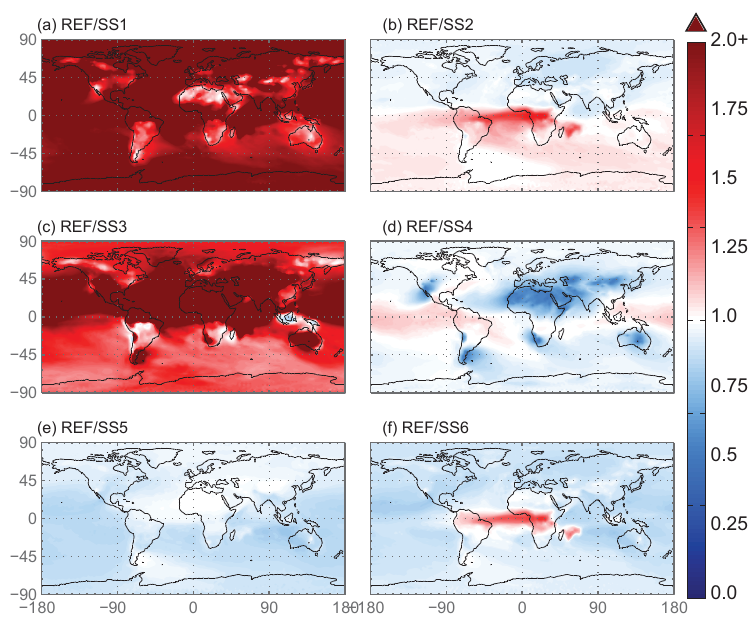
Figure 8. The spatial distribution of the Fes deposition ratio of the reference case over the six sensitivity studies. SS1 corresponds to the case with proton-promoted iron dissolution and no processing via organic ligand dissolution enhancement. The processing mechanism for SS2 is identical to the reference case; however, it uses a sulfate proxy for calculating model oxalate concentrations instead of the OC proxy used in the reference case. SS3 corresponds to a simplified dissolution mechanism defined in Hand et al. (2004); a decay rate is applied when iron comes into contact with a cloud. The SS4 simulation has the same processing mechanism as the reference case; however, the spatial dependence of total and soluble iron on mineralogy at emission is replaced with the average values for these variables from the reference case. SS5 and SS6 are identical to the reference case and SS2, respectively, with the exception of prescribing the pH at 1 when sulfate concentrations exceed calcite concentrations. White indicates no change, red indicates that the deposition in the reference case is higher than the sensitivity study and blue indicates higher deposition compared to the reference